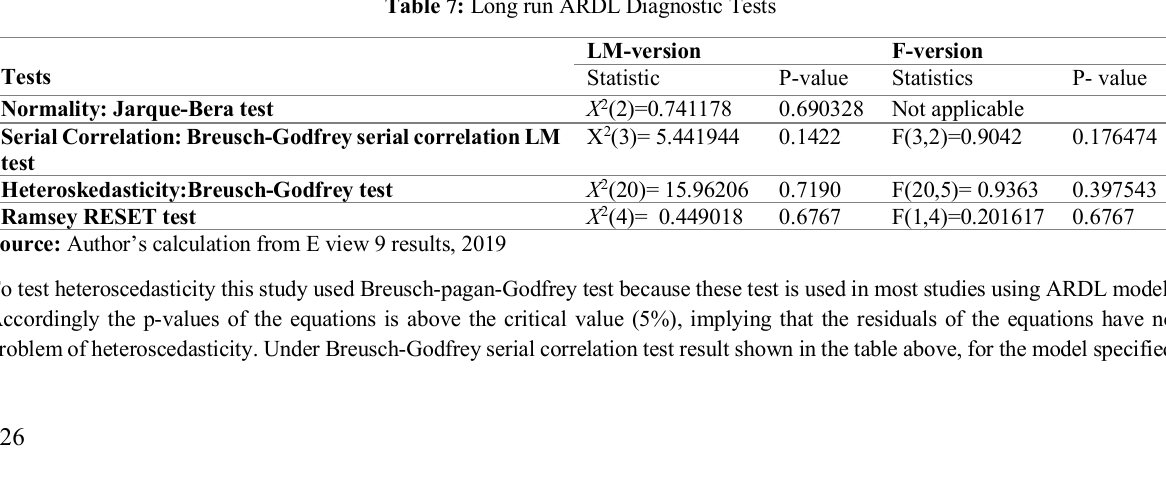
Table 7: Long run ARDL Diagnostic